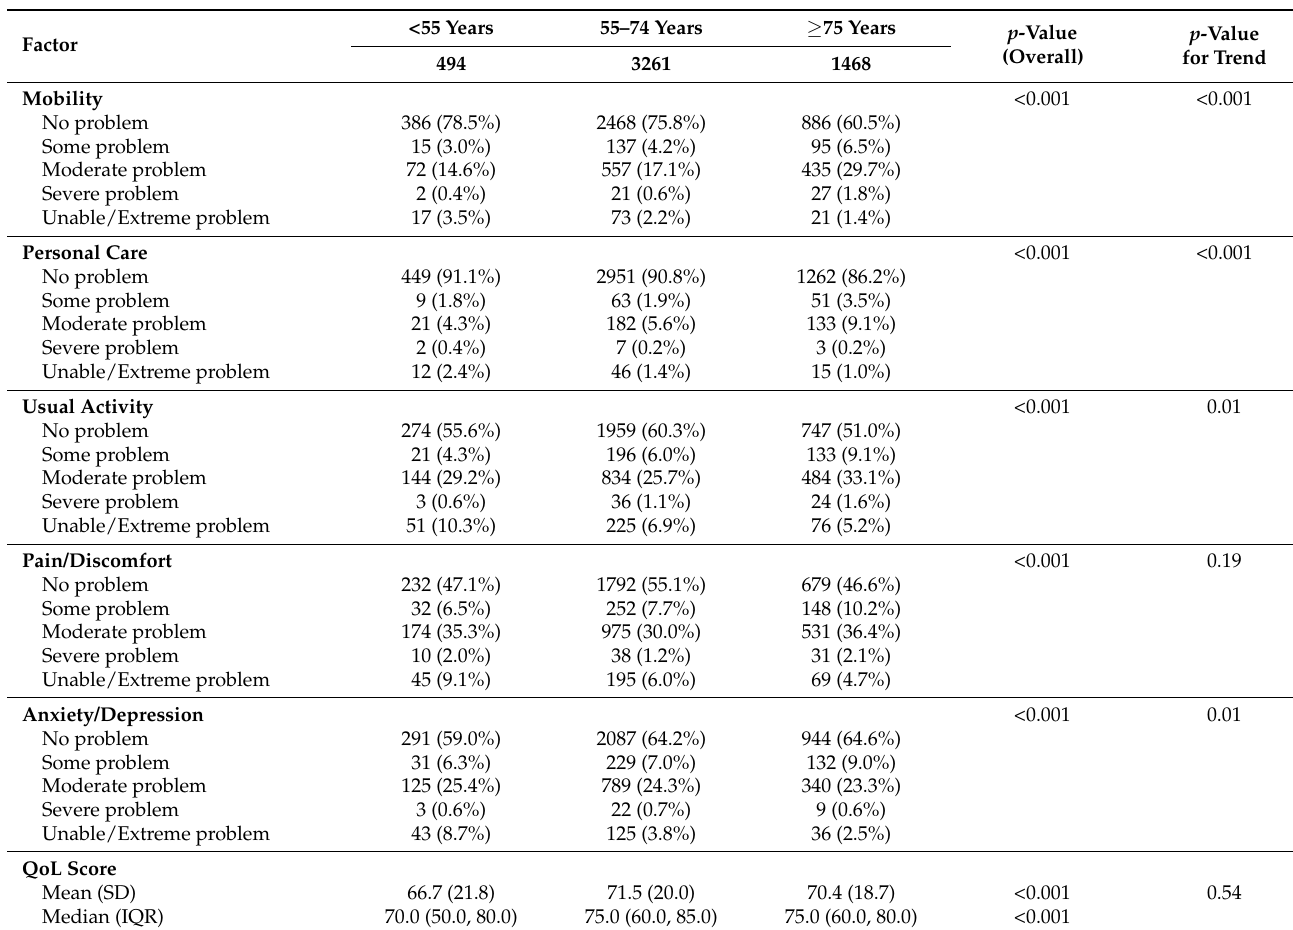
Table 3. Assessing QoL descriptive system and VAS for difference by different age